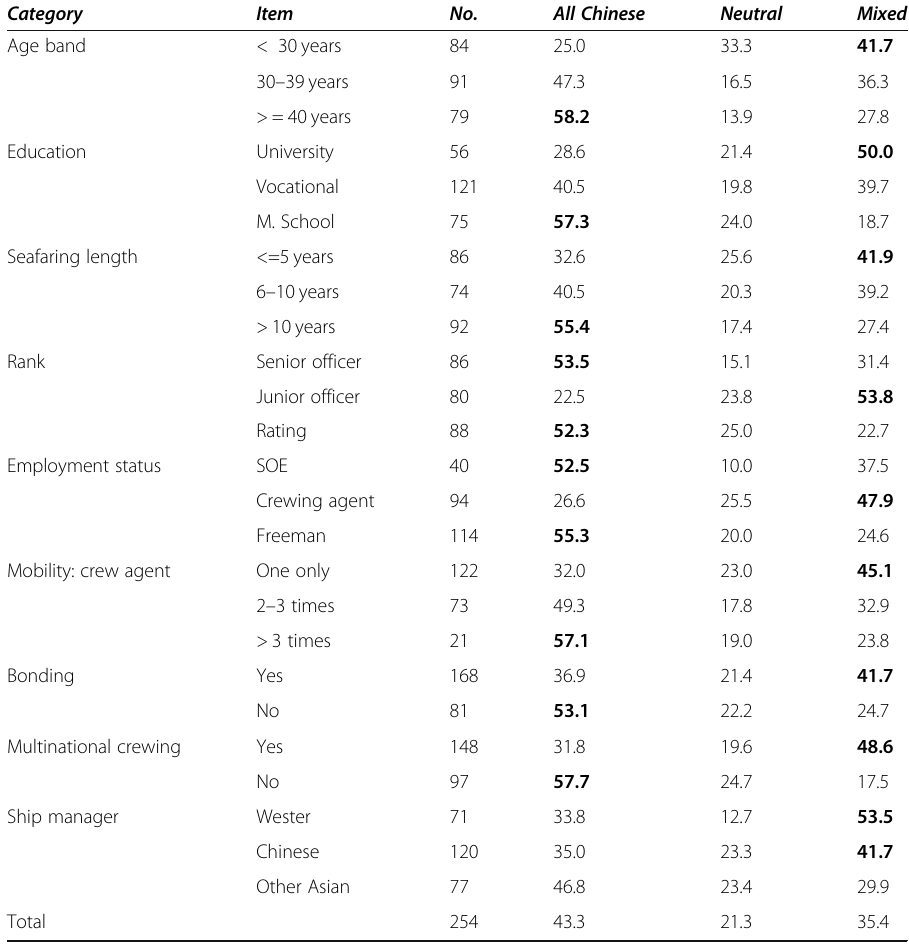
Table 10 Preference of multinational crewing pattern by selected factors Category Item No. Age band